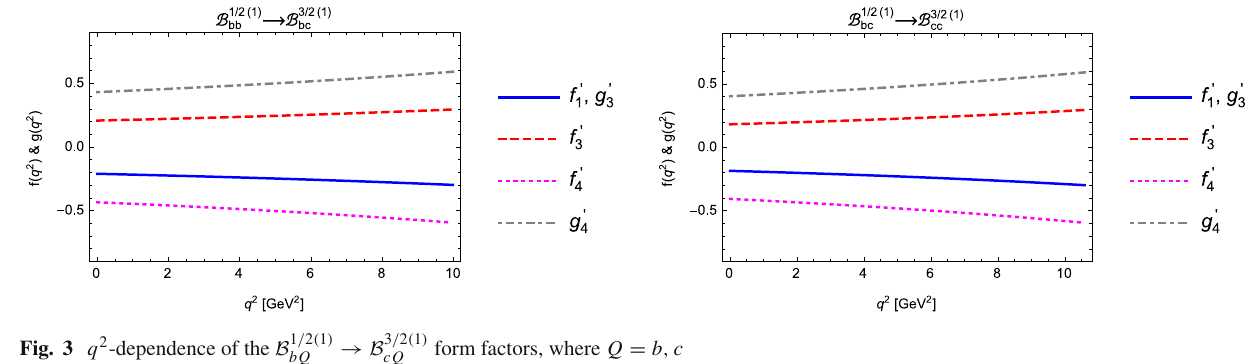
Fig. 3 q 2 -dependence of the B 1